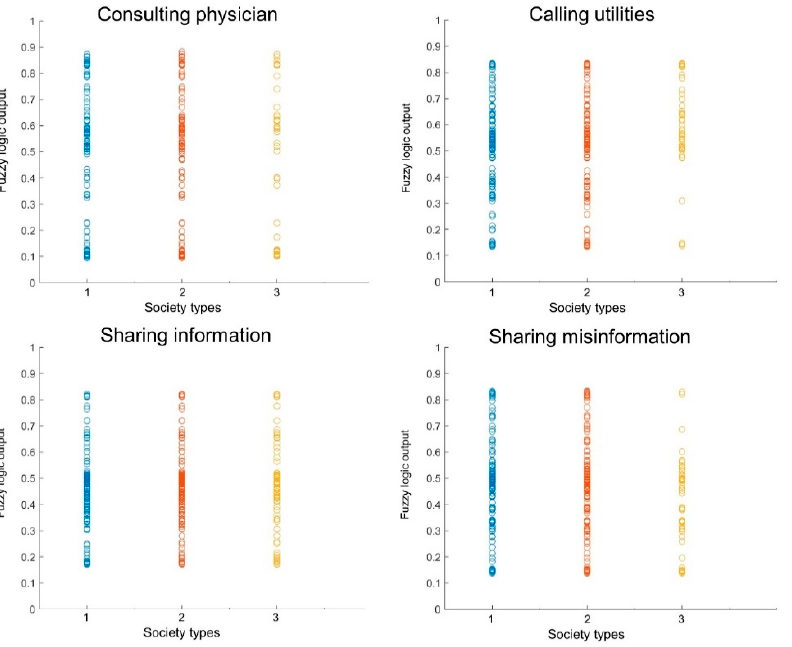
Figure 11. Scatter plot of the fuzzy logic system output in scenario three for the three different society types and the four different possibly taken actions.